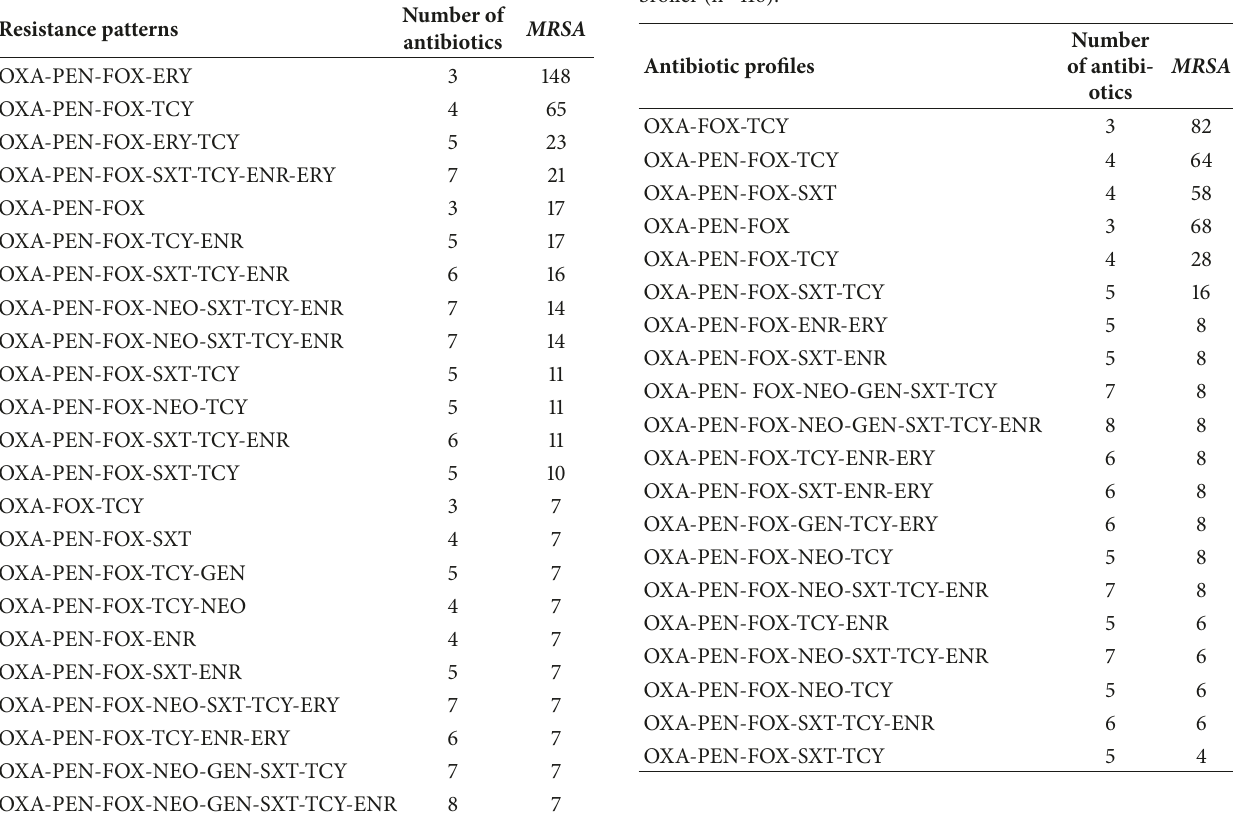
Table 5: Antibiotic resistance patterns of MRSA isolated from broiler (n=416).